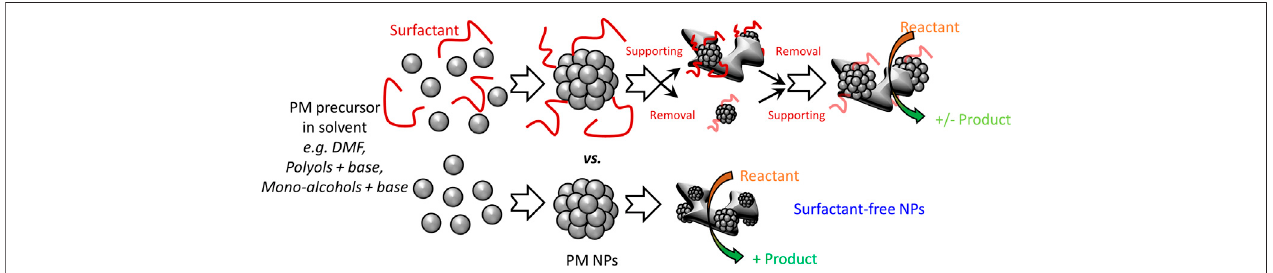
FIGURE 1 | Schematic representation of some colloidal syntheses of PM NPs and illustration of the bene fi ts of surfactant-free approaches to develop supported catalysts with controlled NP size and loading.